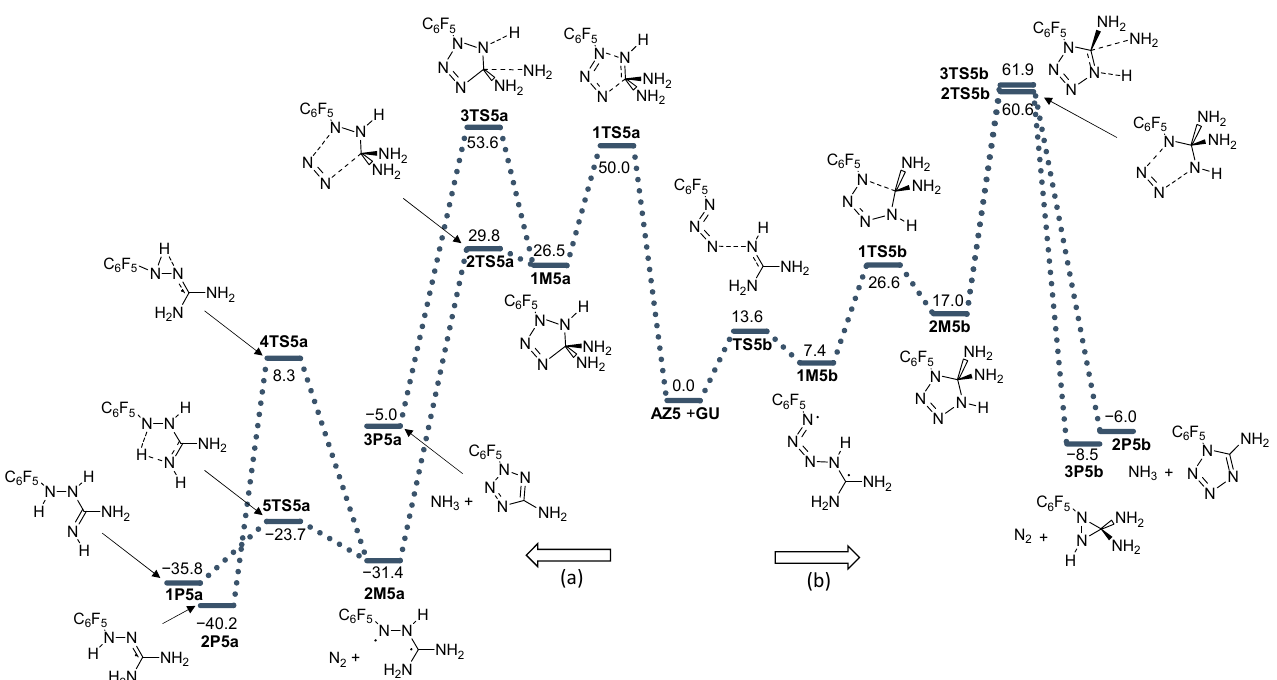
Figure 7. Energy profile for the addition of azide AZ5 with guanidine GU . Energies relative to reactants are given in kcal mol − 1 . ( a ) and ( b ) denote two modes of azide addition to GU . The replacement of the azide hydrogen atom with different functional groups did not lead to a significant change in the geometry of the TS structures for cycloaddition when the carbon atom approached the azide terminal N3 atom (a reaction direction) (Figure 8). The synchronous cycloaddition process is energetically more favorable for 2.5– 4.2 kcal mol − 1 compared to hydrazoic acid AZ1 . The lowest energy barrier was computed for the reaction of guanidine with AZ5 (introduction of the perfluorophenyl group). Additionally, the benzoyl group is preferable when compared to phenyl, which is in good accordance with the larger cycloaddition reactivity of benzyl compared to phenyl azide [32].